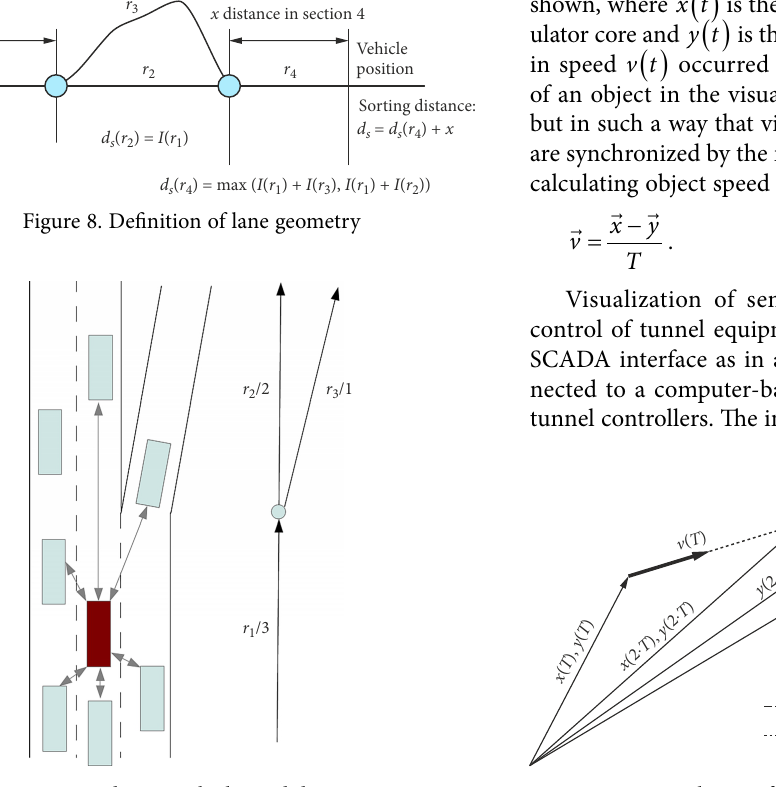
Figure 9. Adjacent vehicles and distances Figure 10. Interpolation of vehicle coordinates for